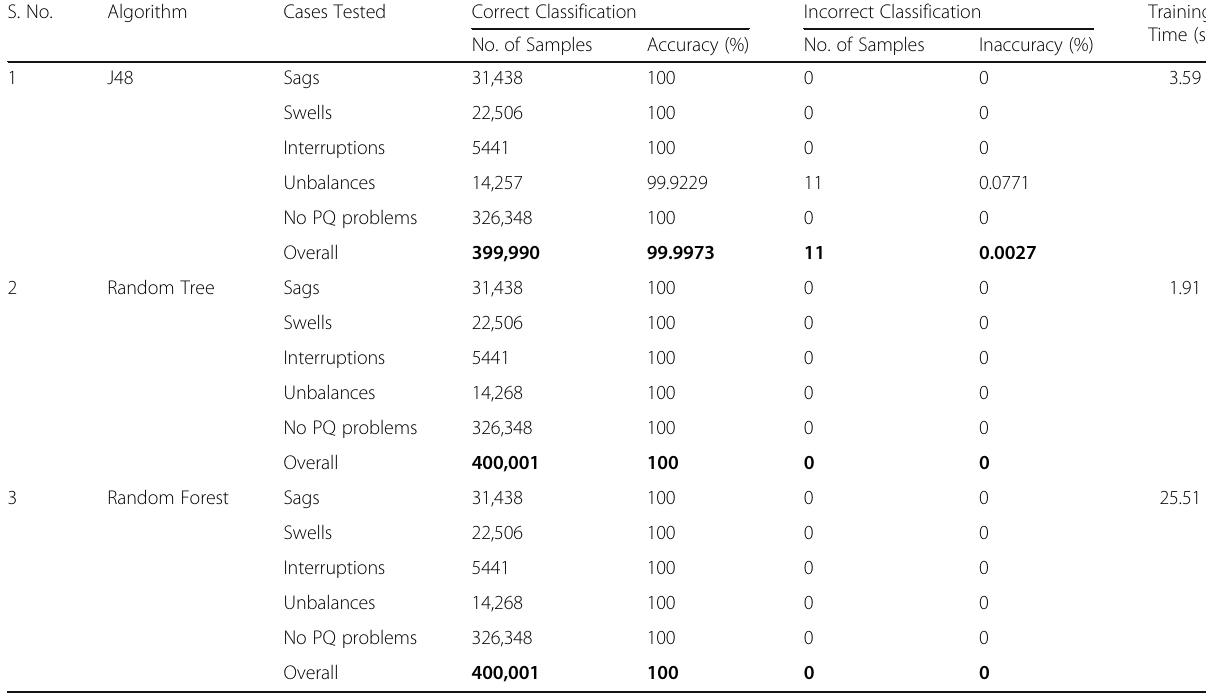
Table 2 Comparison of Data Mining Algorithms with 4 attributes for evaluation on training set S. No.